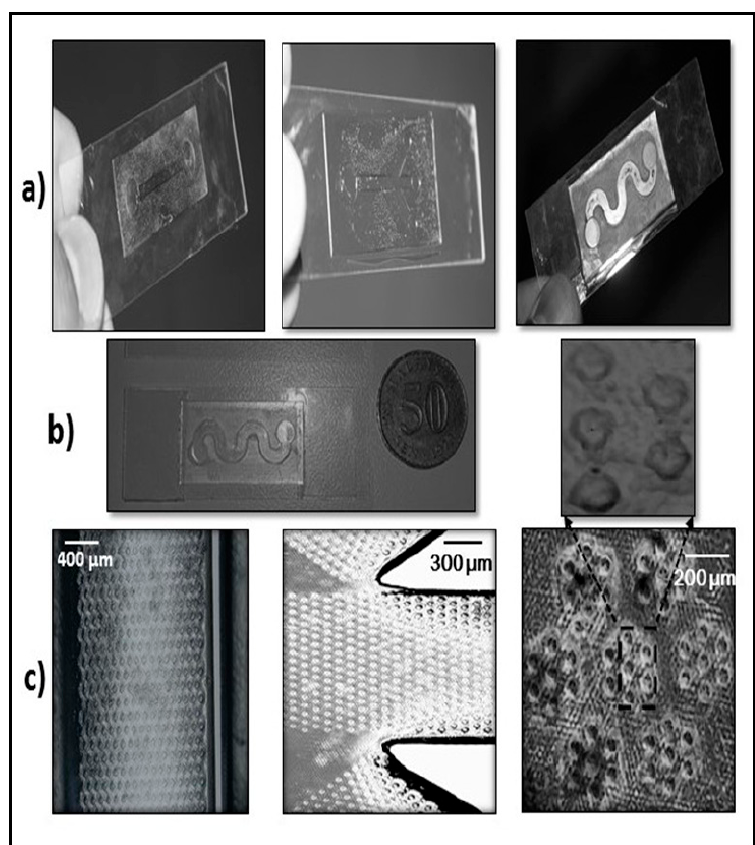
Figure 4. Illustration of the grayscale photolithography process.